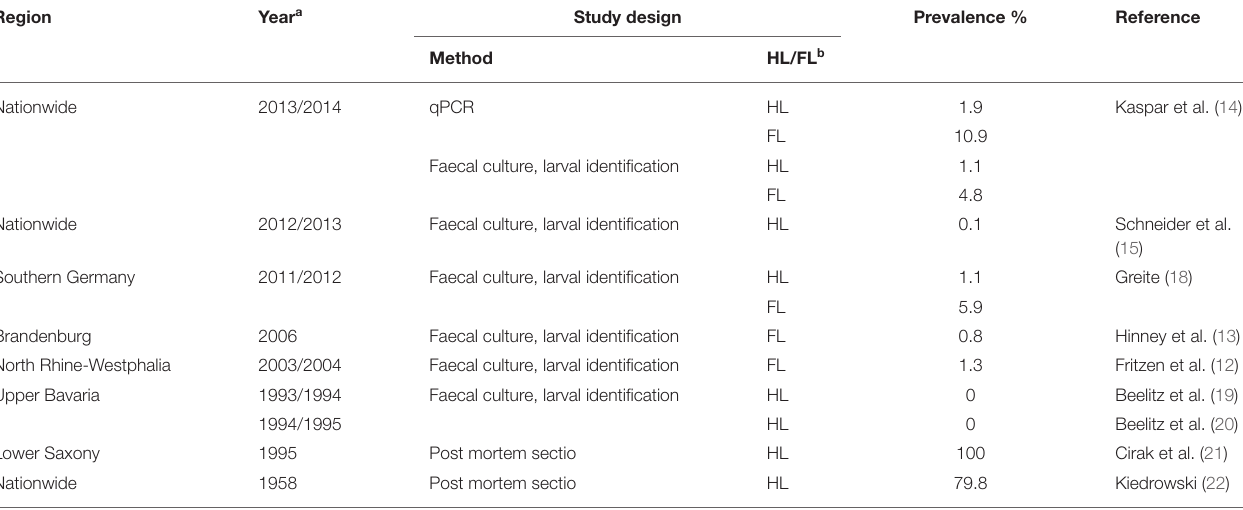
TABLE 1 | Prevalence of Strongylus vulgaris in former studies conducted in Germany.